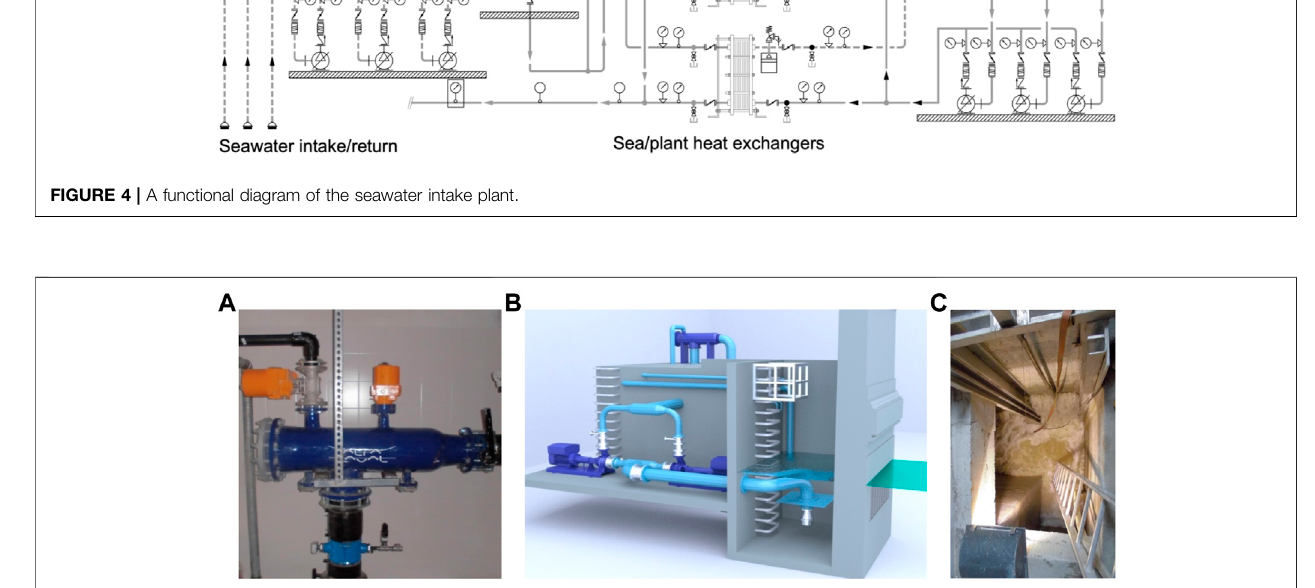
Figure 2 , different colors are used to indicate the categories in each block reported here. Figure 6 shows the heated volume of the categories that belong to each type as a percentage of the total heated volume of the buildings of that type. In this way, it is possible to individuate the category that is to be considered representative of all buildings of that type on the basis of its volume signi fi cance in the total heated volume of that building typology. In Figure 6 , the four selected categories are indicated by an arrow. A table in Figure 6 also indicates the percentage volume of these selected categories with respect to the total building volume in the area. For each of these four categories, an archetype building is selected to characterize the category and thus all the types in the stock. The archetypes selected in this case study are listed in Table 2 , which includes their main characteristics and simulation parameters. The hourly heating or cooling load pro fi le of each archetype is calculated using the EnergyPlus code, a comprehensive and robust building simulation program. The EnergyPlus calculation is based on the contemporary solution of the global energy balance of each thermal zone of the building, taking into account the contribution of the HVAC system to maintain the thermal control setpoints (Yang et al., 2019). For each archetype, the hourly load is divided by the relative building volume to estimate an hourly load intensity that is adopted for all buildings belonging to the relative type. Consequently, the total load of a building typology is calculated by multiplying this load intensity by the corresponding total building volume.